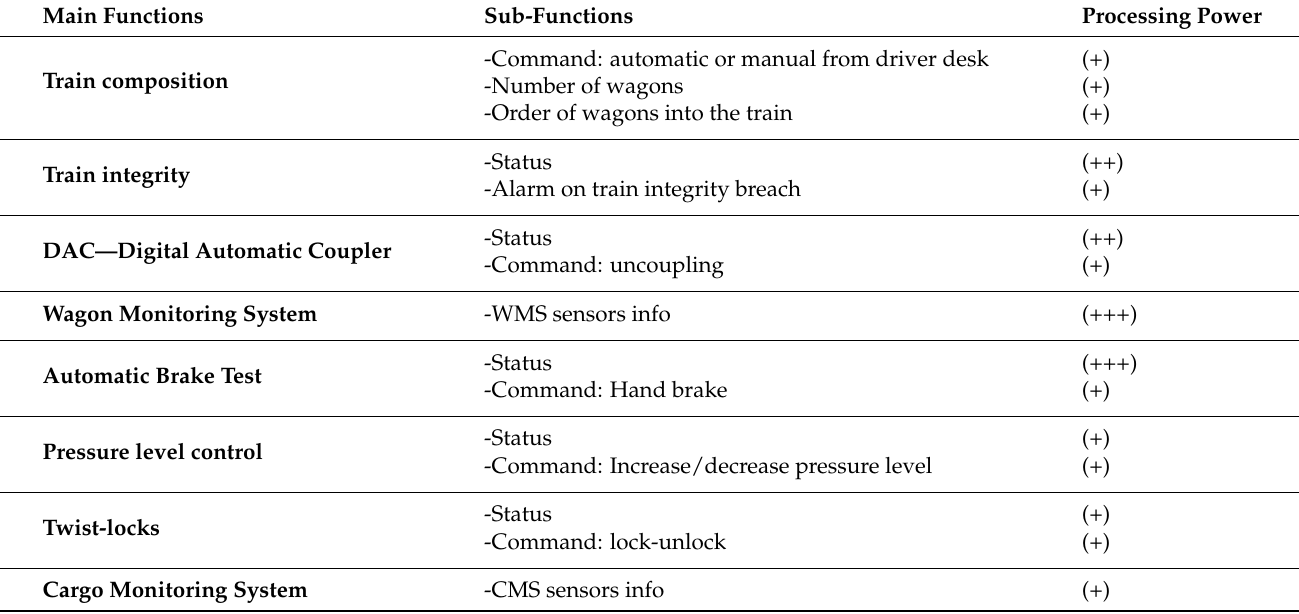
Table 1. Functions for digitalisation and automation around the freight railway